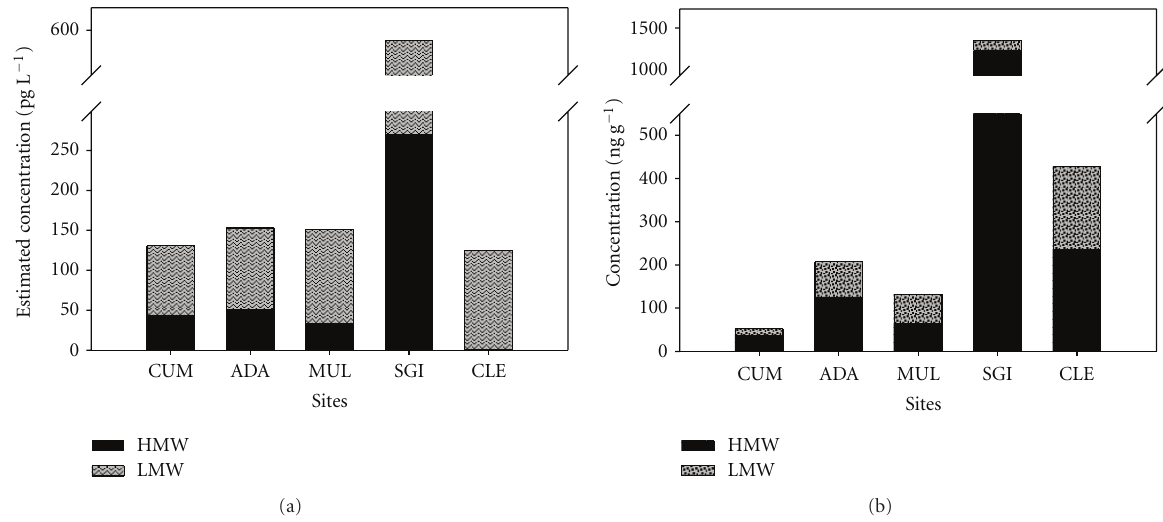
Figure 3: Sum of 15 PAH compounds in the five study lakes (Lough Cummeenoughter (CUM), Lough Adanacleveen (ADA), Mullincrick Lough (MUL), Sgilloge Lough (SGI), and Cleevaun Lough (CLE)) with high molecular weight (black) and low molecular weight (grey) portions shown. Concentrations of PAHs in lakes (a) estimated from SPMDs deployed during the period from July, 2009, to January, 2010. Concentrations of PAHs in soils (b) collected in October